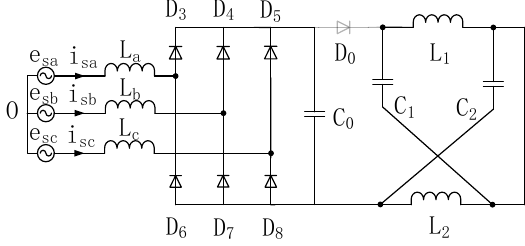
Figure 5. The equivalent circuit of the Z-source wind power generation system in the shoot-through zero state.